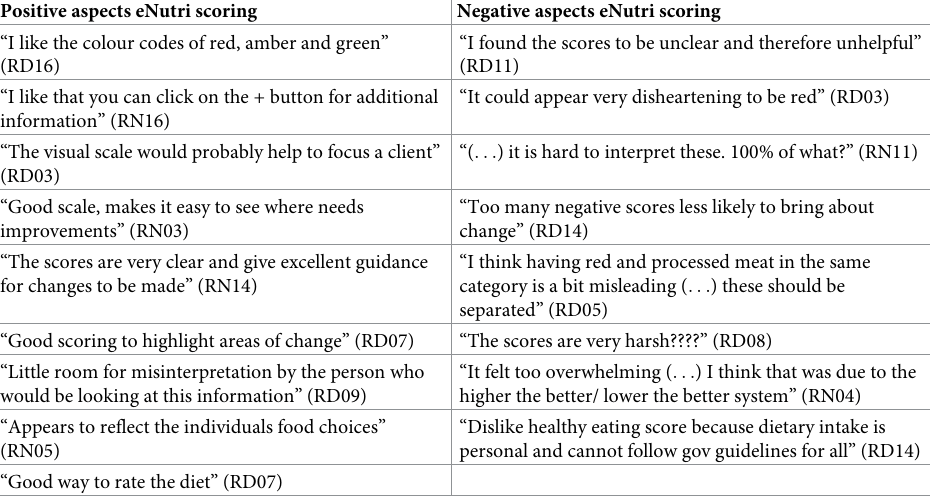
Table 4. Quotes identifying positive and negative aspects of the eNutri automated personalized nutrition app scoring system identified by nutrition